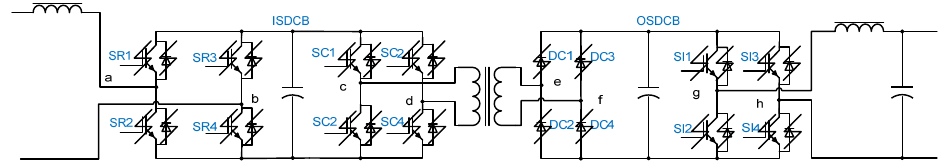
Figure 4. Possible faults of power switches of the EPT.